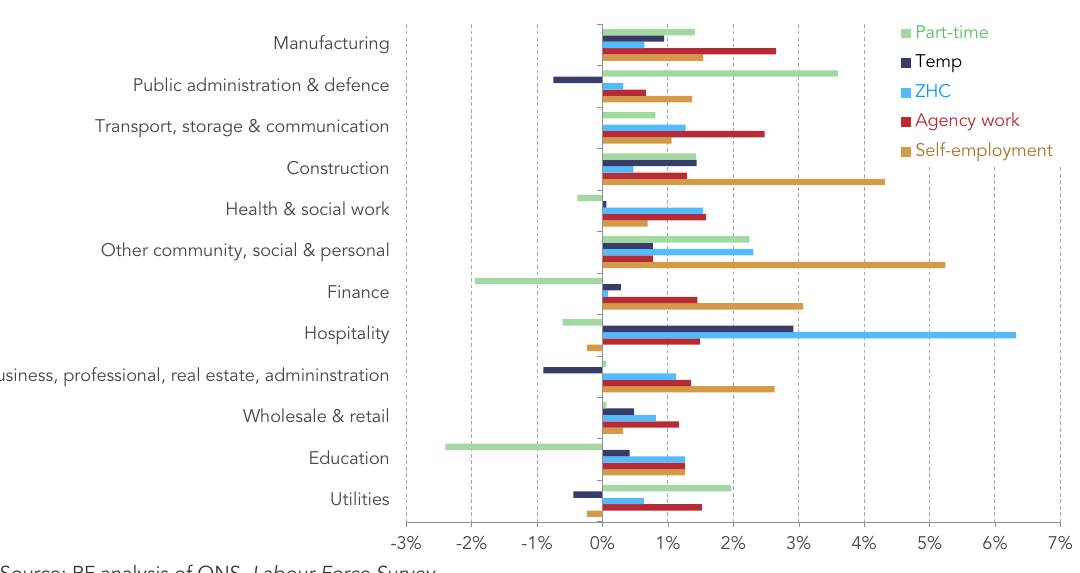
Figure 32: Different sectors use different forms of atypical work Percentage point change in various forms of atypical work: